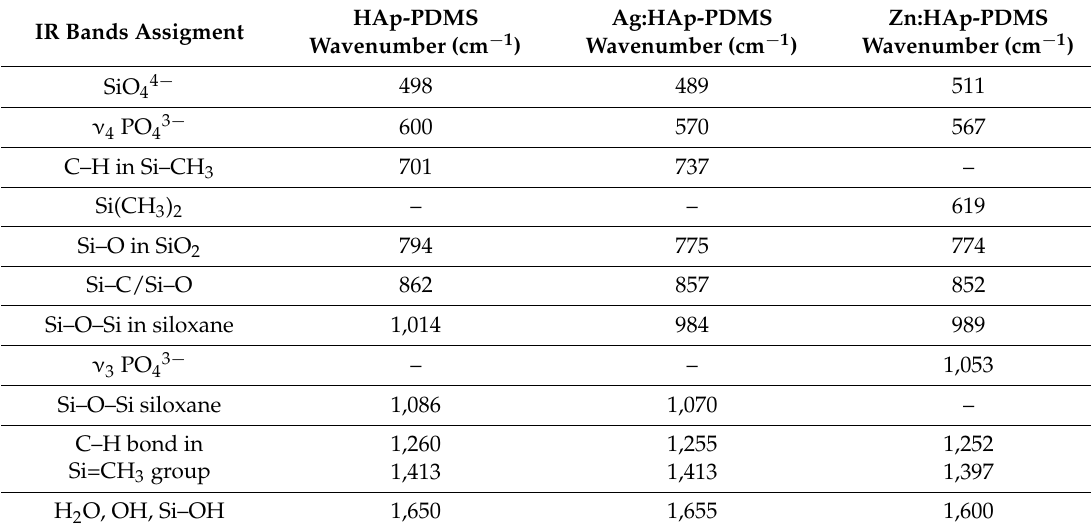
Table 1. IR vibrational bands observed in the FT-IR spectra of HAp-PDMS, Ag:HAp-PDMS and Zn:HAp-PDMS composite